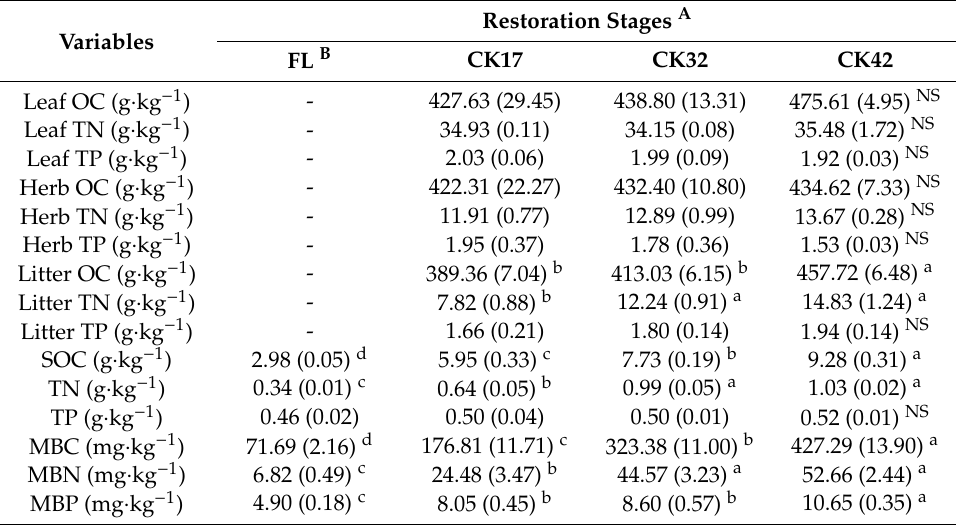
Table 2. The C, N, and P contents in leaf, herb, litter, soil, and microbial biomass at di ff erent stages of vegetation restoration.